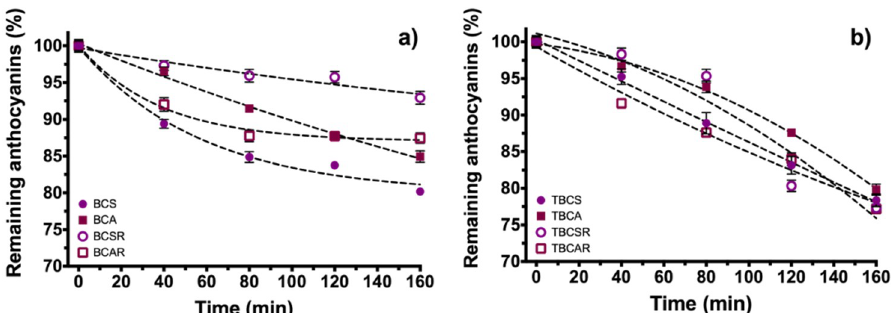
Figure 4. Anthocyanin content in black carrot extracts as function of time under UV radiation (315–